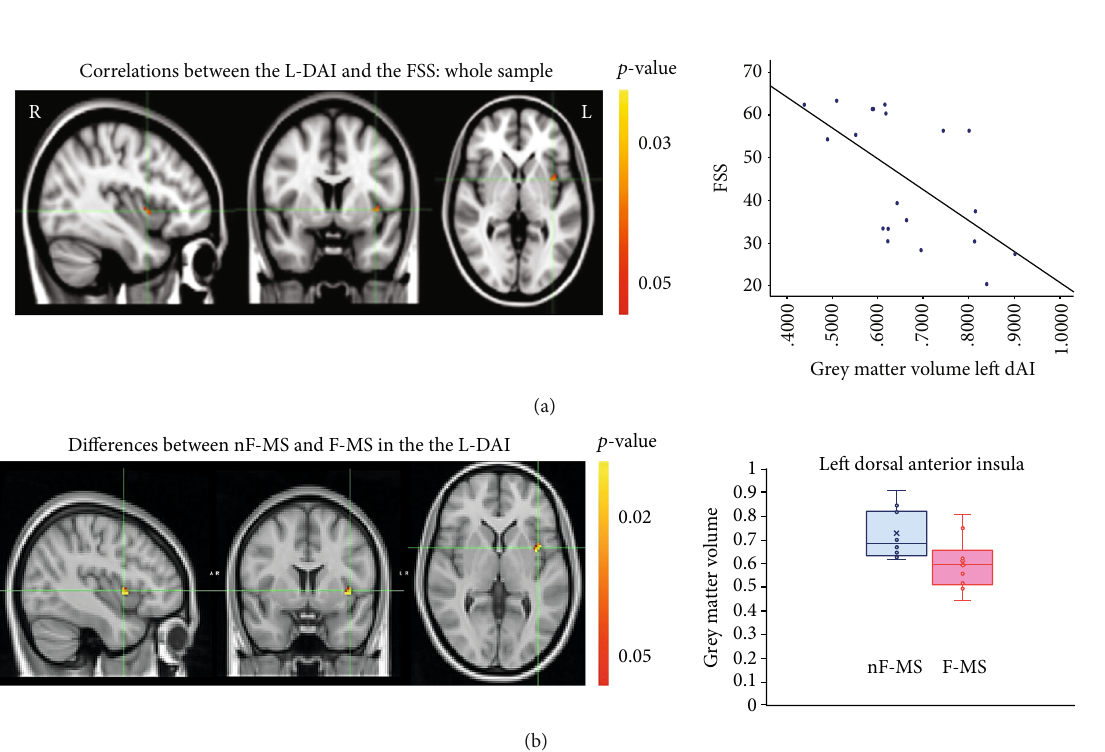
Figure 1: (a) Correlations between the dorsal anterior insular cortex (L-DAI) and the level of fatigue (FSS). In the y -axis, the di ff erent scores in the FSS are presented (higher scores mean more fatigue). In the x -axis, di ff erent values of GM volume in the L-DAI are presented. (b) Signi fi cant di ff erences between the nF-MS and F-MS groups in the L-DAI. In the y -axis are represented the GM volume. In the x -axis, there are represented the two groups (nF-MS and